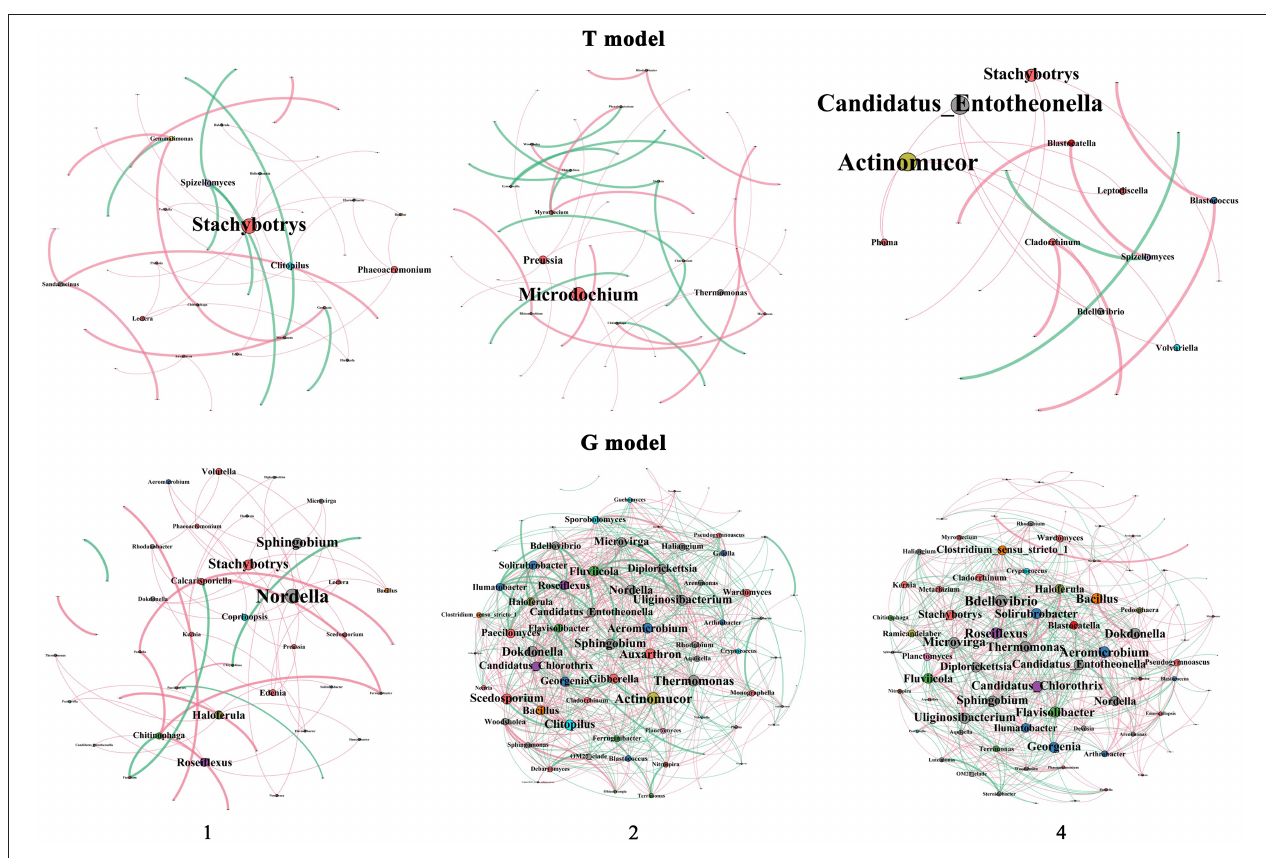
FIGURE 5 | Coccurrence network of the microbial community between the intercropping patterns. 1, 2, and 4 indicate intercropping with 0, 1, and 3 species of aromatic plants, respectively, to facilitate regression analysis. T model, intercropping with aromatic plants in the clean tillage soil; G model, intercropping with aromatic plants in the natural grass